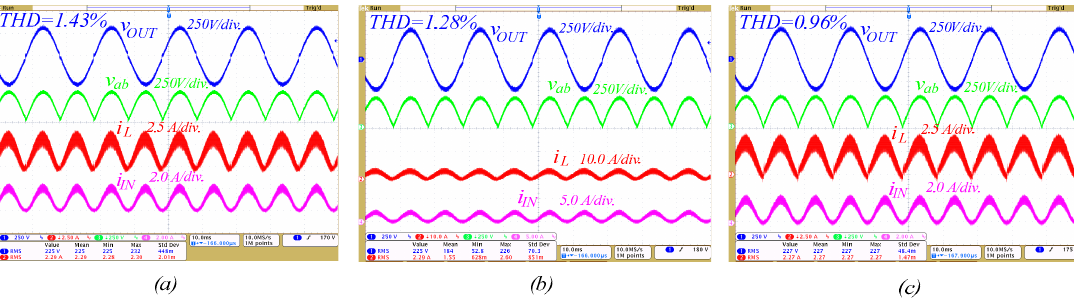
Figure 10. Experimental results for V in = 250 V, P in = 250 W in the inverter mode without synchronous switching and separate control ( a ), without synchronous switching and with separate control ( b ), with synchronous switching and with separate control ( c ).